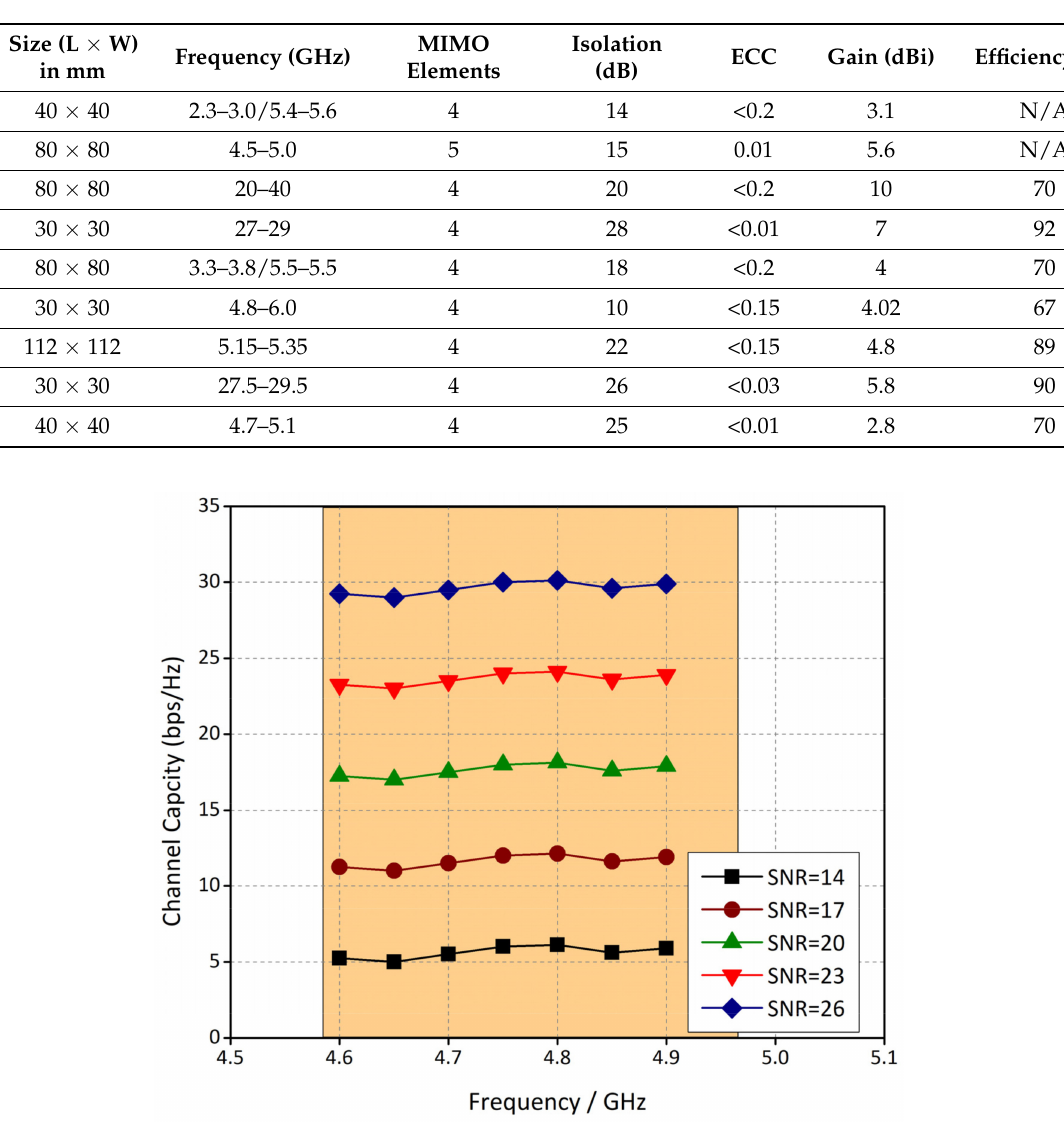
Table 2. Comparison table of proposed MIMO systems.